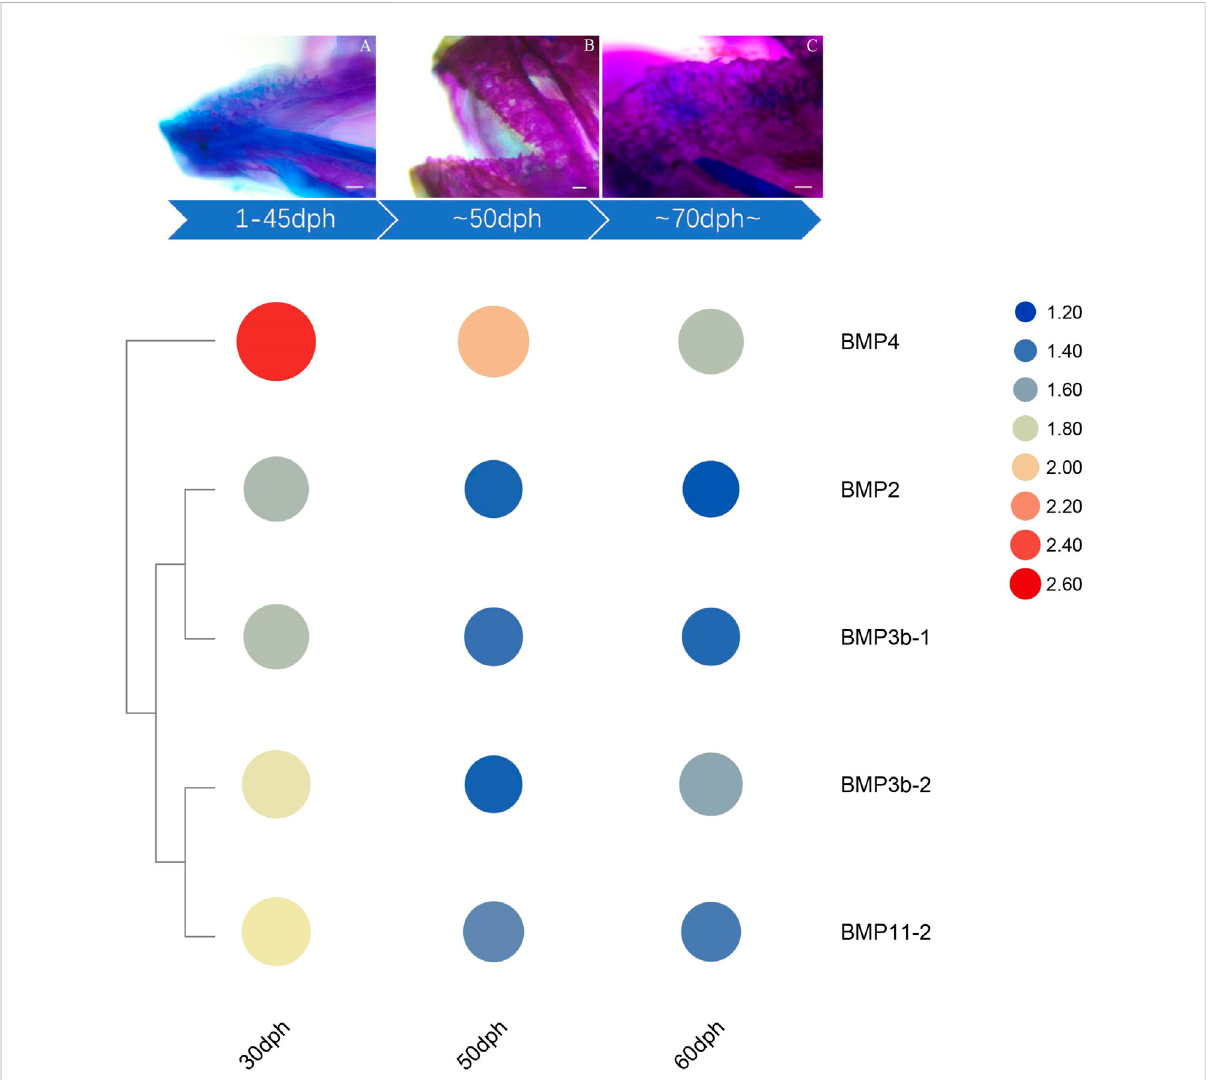
FIGURE 10 Expression of beak-like teeth-speci fi c BMP genes at critical nodes in beak-like teeth development of O. punctatus . The upper panel indicates the results of alizarin red bone staining at critical time of beak-like teeth development, and the lower panel of heatmap indicates the chronological expression of BMP genes that are highly expressed in the surrounding tissue of the beak-like